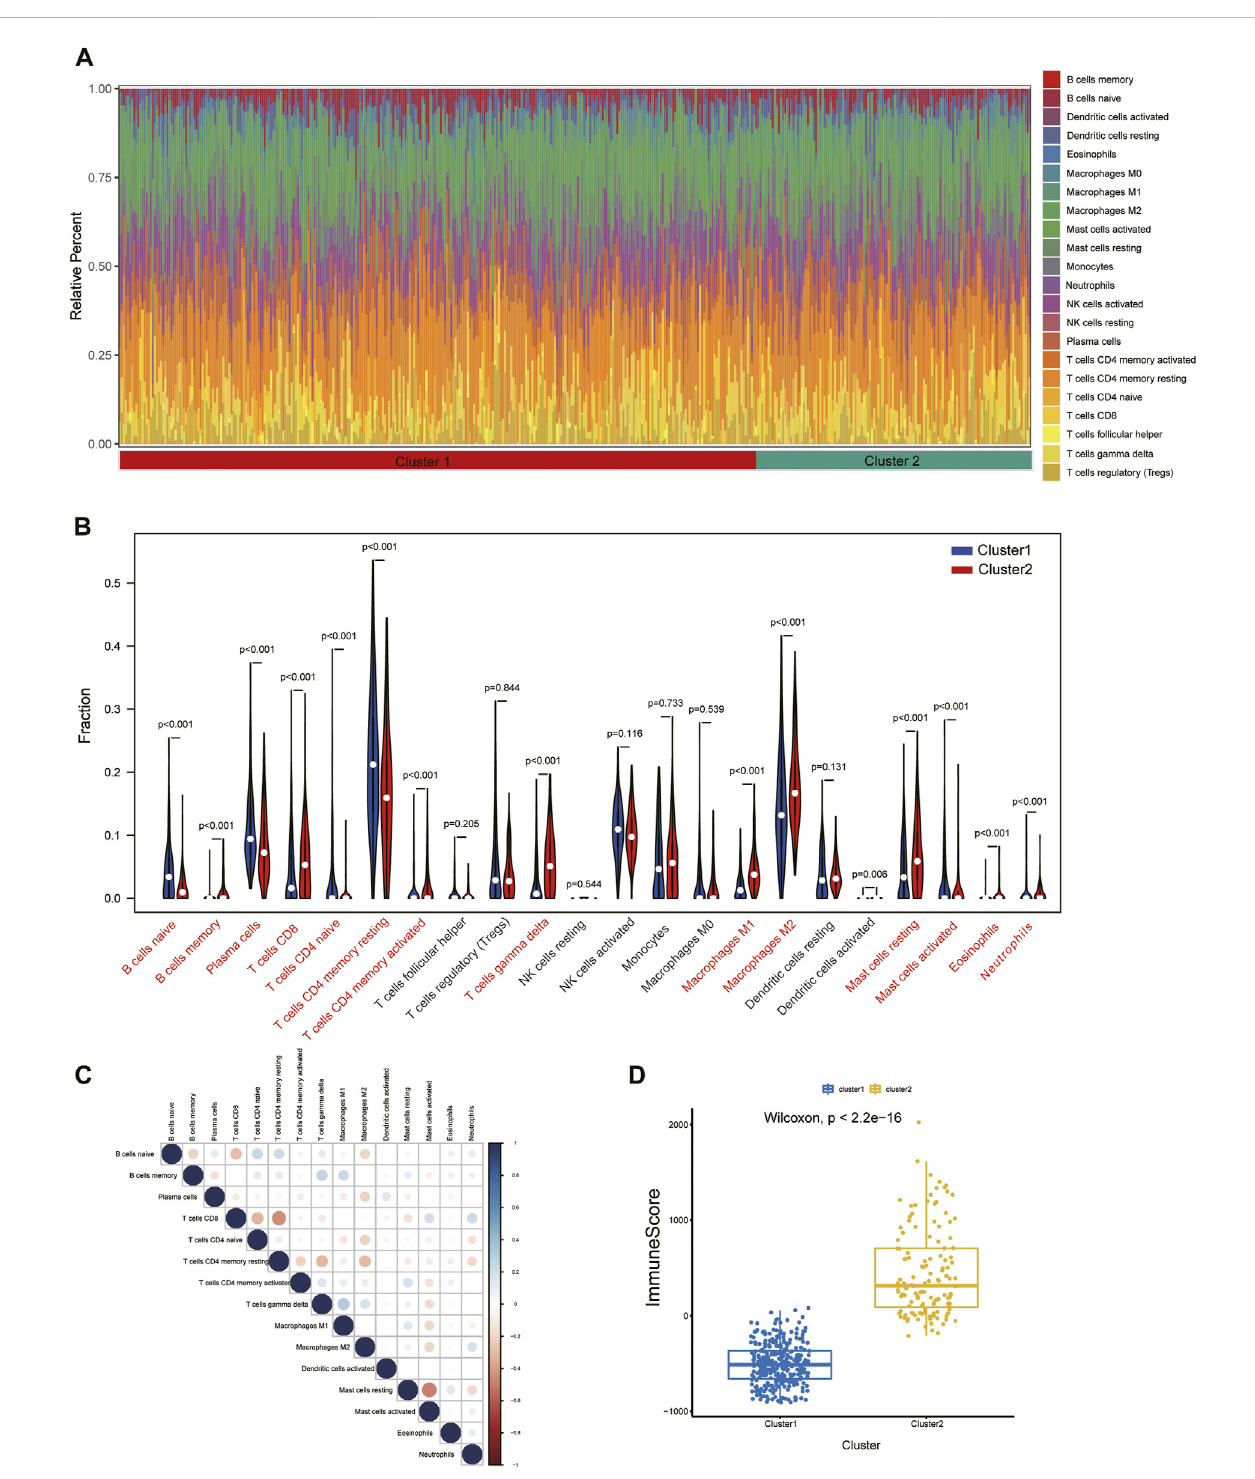
FIGURE 10 Immune cell in fi ltration differences among clusters. (A) Immune microenvironment of cluster1 and cluster2. (B) Box plots showing variation in immune cell in fi ltration among clusters. (C) Relevance heatmap of immune cells with disparities. (D) Estimated Immunoscore among subtypes.